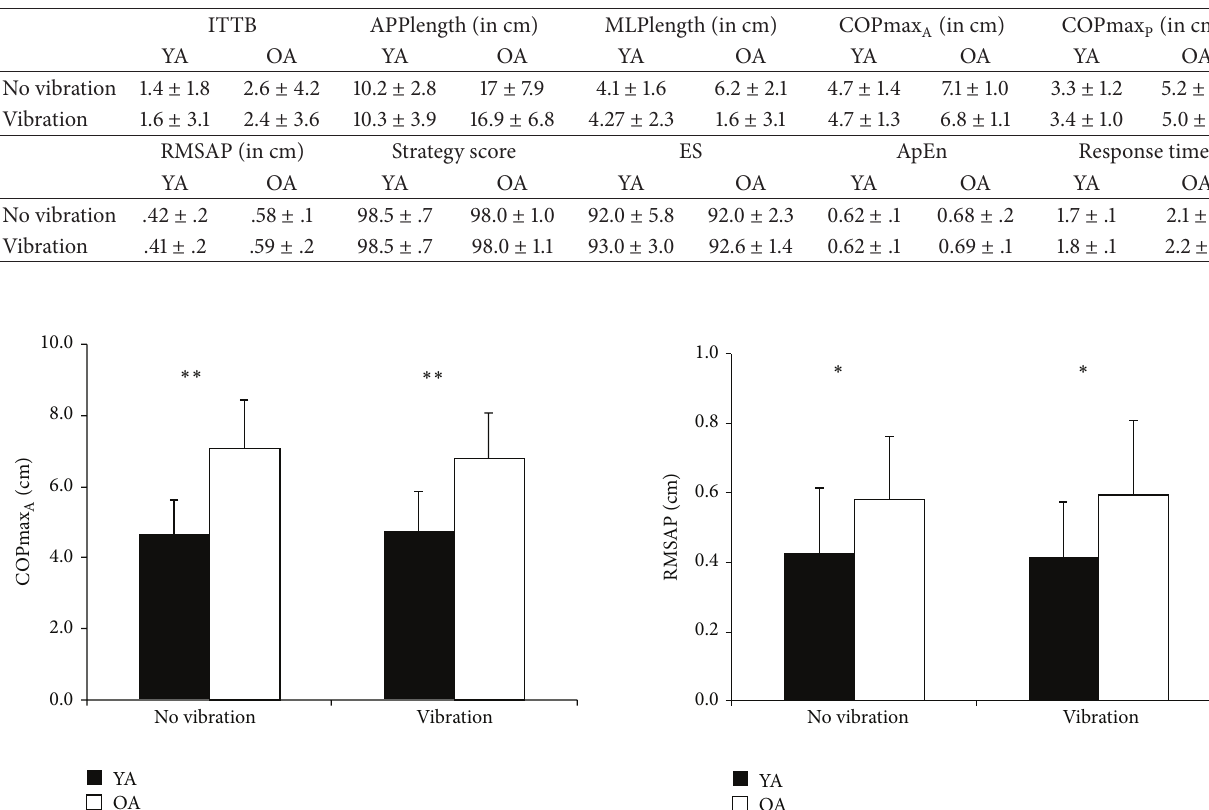
Table 2: Means and standard deviations of postural performance, control, and cognitive response time of younger adults (YA) and older adults (OA) with and without vibration.